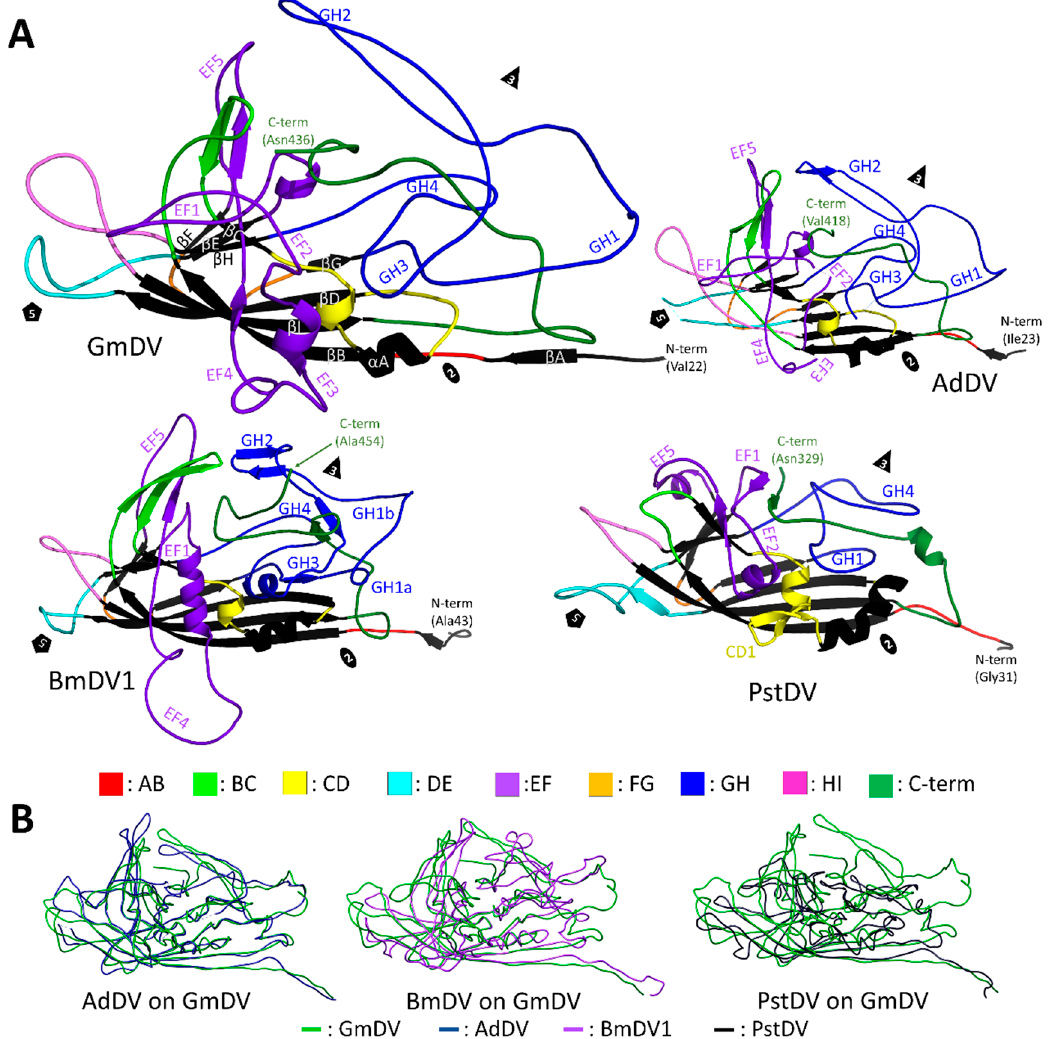
Figure 12. The densovirus VP structure. ( A ) Cartoon ribbon diagrams of the ordered common VP structures of GmDV and AdDV (top), BmDV1 and PstDV (bottom). The first ordered N ‐ terminal residue and C ‐ terminal residue are labeled. The conserved β‐ core and α A helix are colored in black and labeled in GmDV. Loops and subloops within the large loops are as colored in the key at the bottom and EF and GH sub ‐ loops are labeled. The approximate 5 ‐ fold symmetry axis is marked by a pentagon, the 3 ‐ fold by a triangle, and the 2 ‐ fold by an ellipsoid. ( B ) A GmDV VP structure ( Ambidensovirus ) superimposed on the VPs of AdDV (left), BmDV1 (middle), and PstDV (right). Conformational diversity on the surface loops is evident, especially between GmDV and BmDV, and GmDV and PstDV,